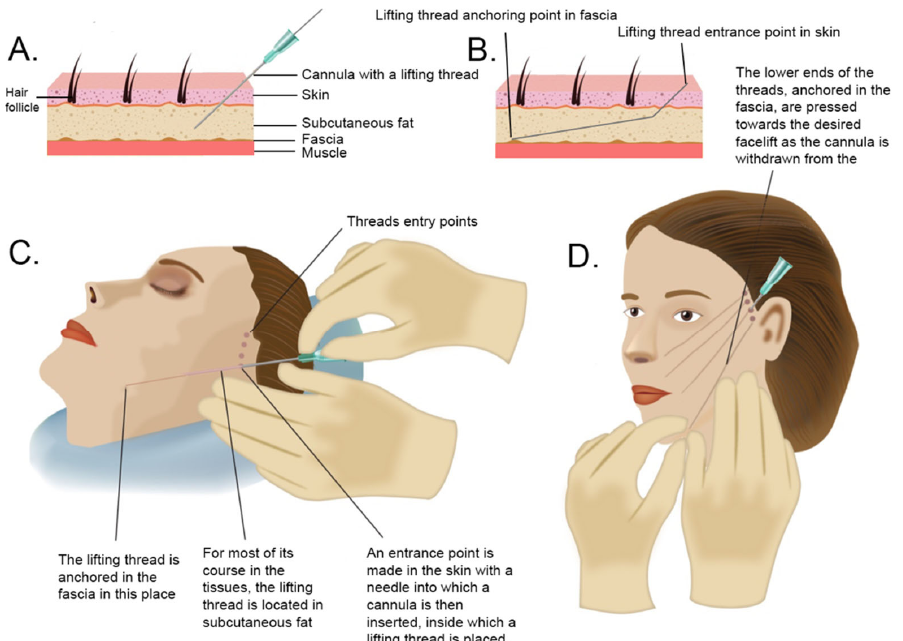
Figure 2. Study flow diagram and post hoc derivative prediction models: screening test and diag- nostic test results. ( A ) Cross-section through the skin and deeper tissues. After making a hole in the skin with a needle, a cannula with a lifting thread inside is inserted into the subcutaneous fat layer. ( B ) Diagram illustrating the technique of thread anchoring in the fascia. ( C ) In order to lift the middle part of the face, the threads are inserted in the area of the temples and in the subcutaneous fat layer led to the area of the cheek, mouth, and jaw line to anchor the thread in the fascia. ( D ) After inserting the cannula into the subcutaneous fat layer, with twisting movements, the cannula is placed in the place of a decent lift and then directed to the deeper layers of fat on the border with the fascia to anchor the thread in it. Then, the lift target point is pressed by the hand, the thread unlocks, and the cannula advances. The lifting thread remains in the tissues.